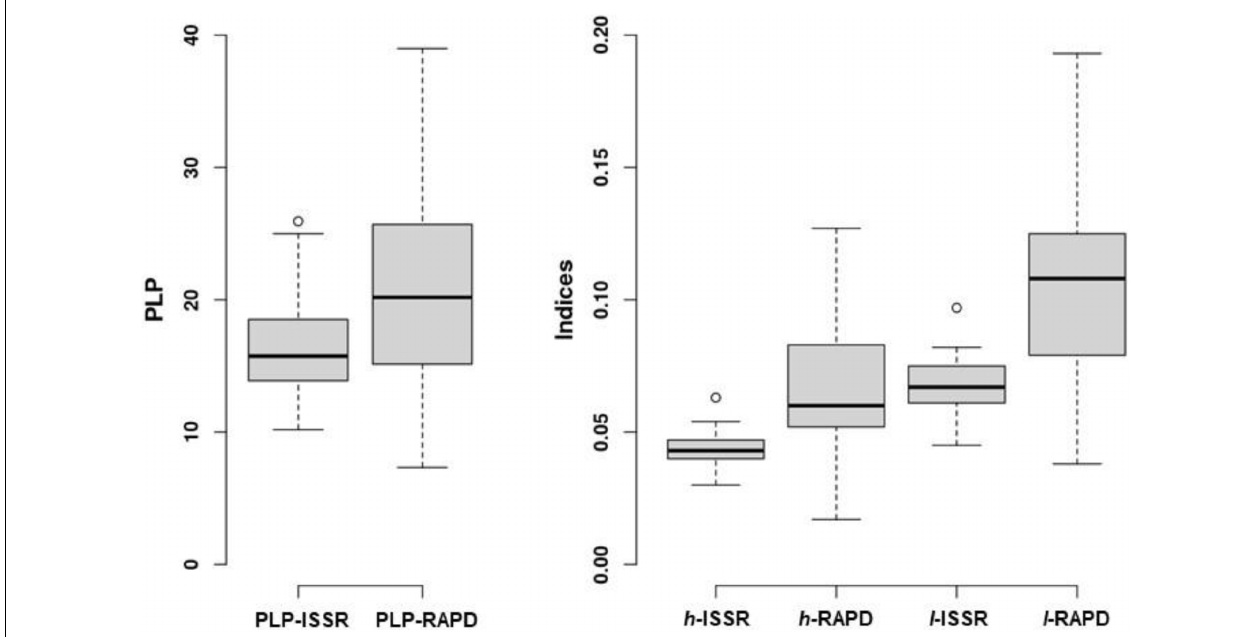
FIGURE 2 | ISSR and RAPD loci based parameters of genetic diversity of 21 Impatiens parviflora populations: PLP, polymorphic loci percentage; indices: h, Nei’s gene diversity; I, Shannon’s information index. The central line of each box indicates the median value; the boxes, the lower (25%) and upper (75%) quartiles, and the whiskers, are from 10 to 90 percentiles (typical range), the points are outliers.